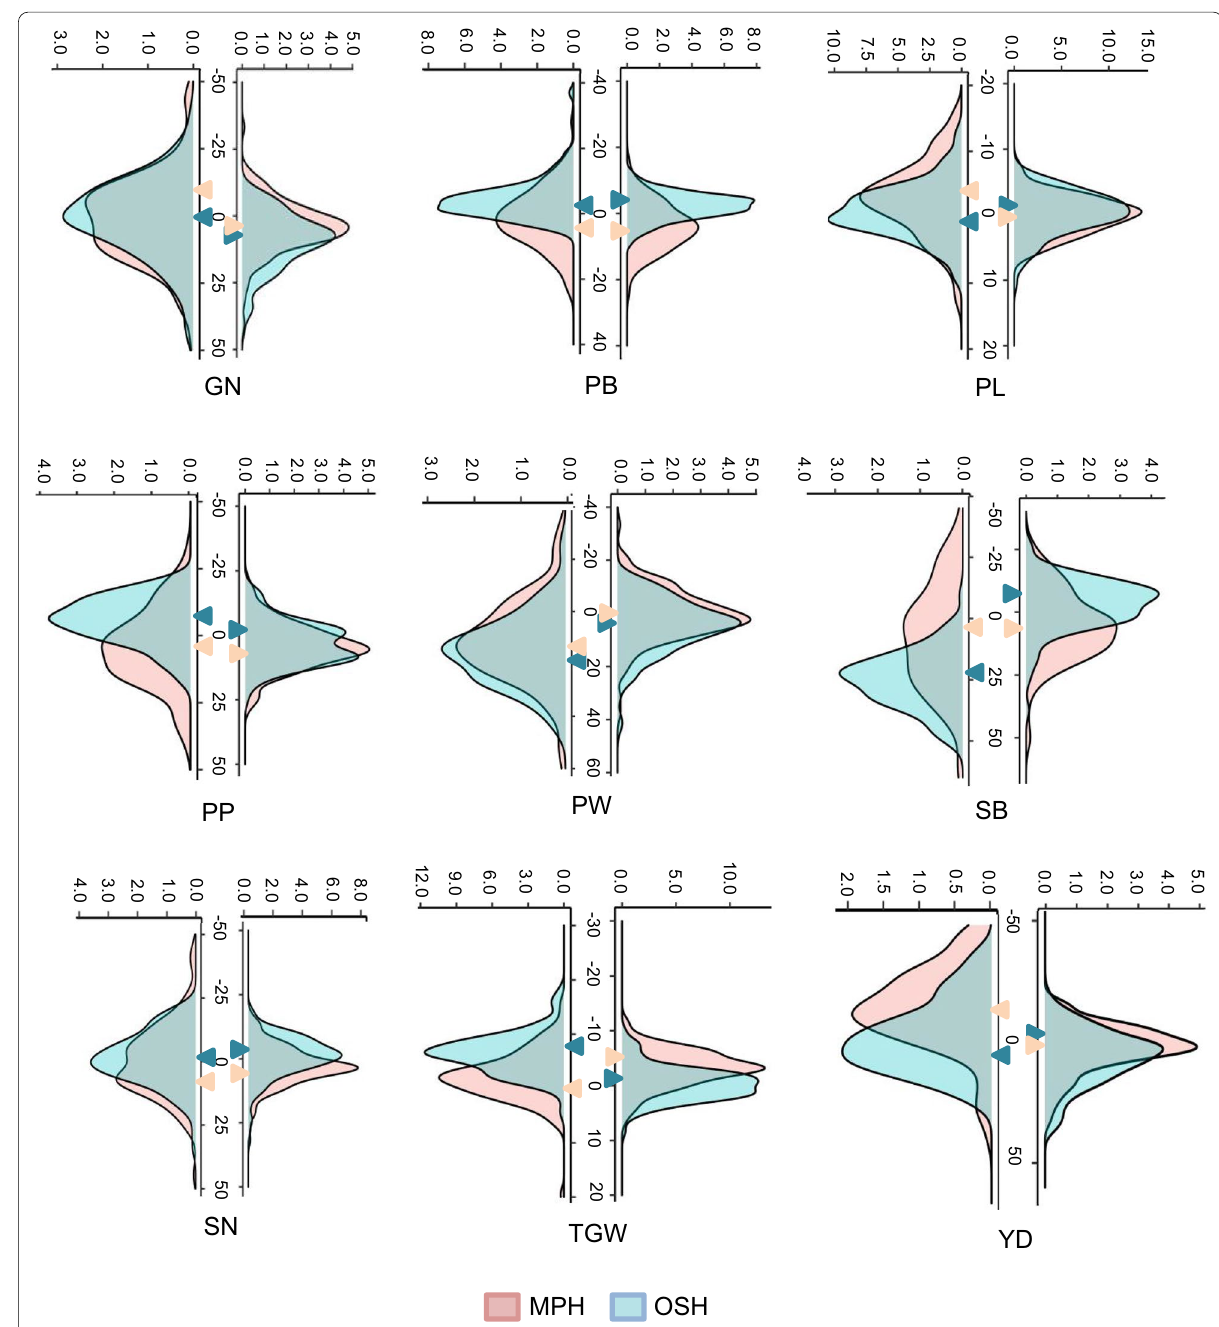
Fig. 2 Distribution of mid-parent heterosis (MPH) and over-standard heterosis (OSH) for yield-related traits. The MPH and OSH of the yield-related traits were evaluated in 2006 (E1) and 2007 (E2), which are on the left and right of each plot, respectively. The y-axis represents the density (%). The x-axis represents the MPH value (%) and OSH value (%) for each trait. The median of each trait is indicated by the the colored triangle. GN, grain number; PB, number of primary branches; PL, panicle length; PP, panicles per plant; PW, panicle weight; SB, the number of secondary branches; SN, spikelet number; TGW, thousand-grain weight; YD, grain yield per